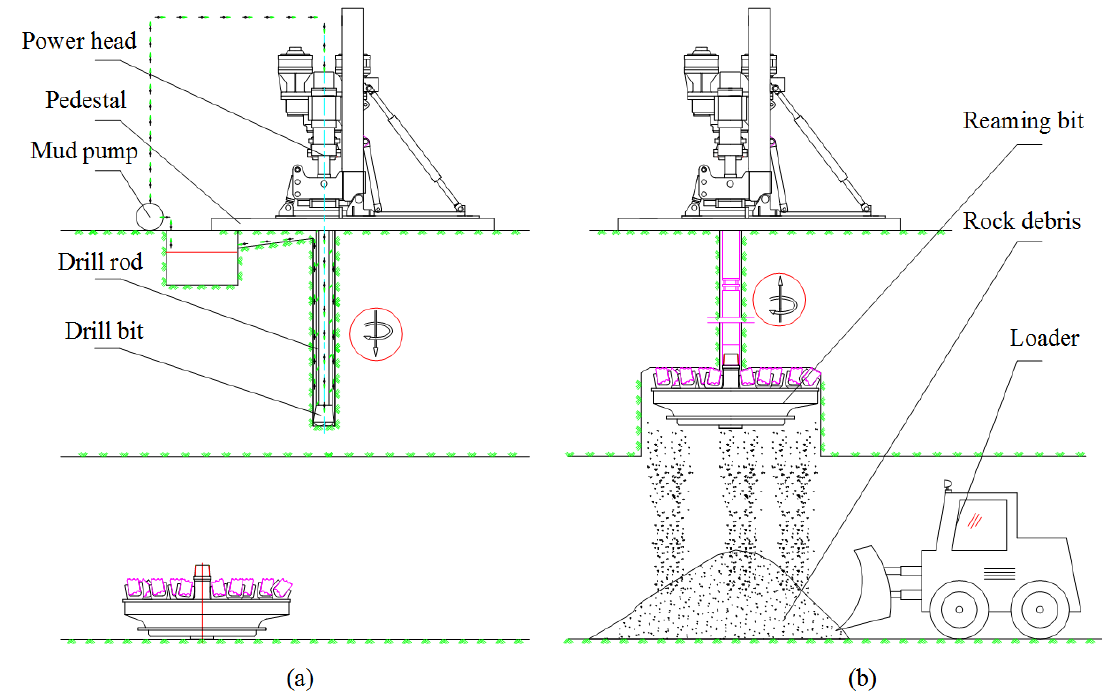
Figure 1. Diagram of the raise boring method: ( a ) pilot hole drilling (top-down); ( b ) back reaming (bottom-up).